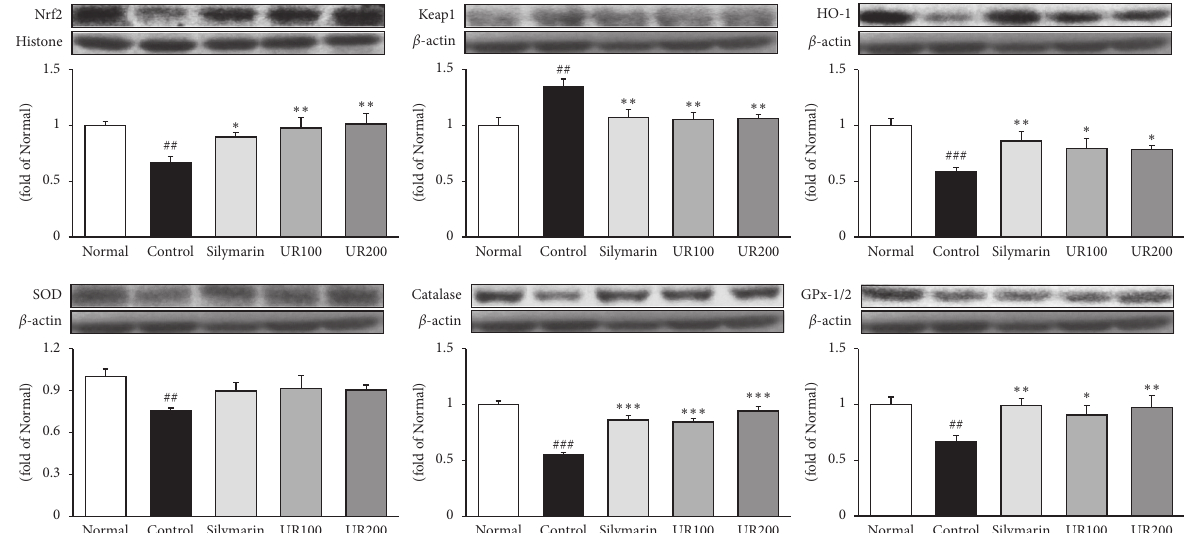
Figure 4: Effect of UR on antioxidant proteins. Effects of UR on the expression levels of Nrf2, Keap1, HO-1, SOD, catalase, and GPx-1/2 by the Western blotting assay. Data are expressed as the mean ± SEM ( n � 7). Significance: ## p < 0 . 01 and ### p < 0 . 001 vs. the normal group and ∗ p < 0 . 05 ∗∗ p < 0 . 01, and ∗∗∗ p < 0 . 001 vs. the ALI control group.